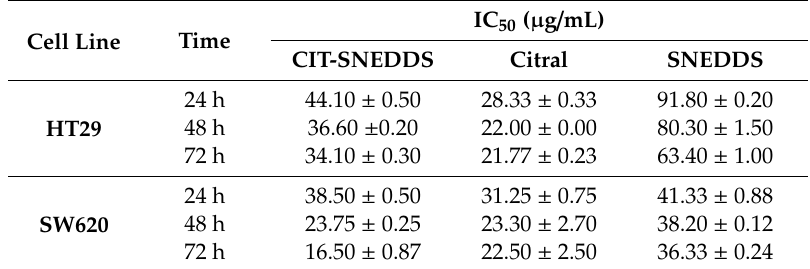
Table 6. The summary of antiproliferative e ff ects of citral-loaded self nano-emulsifying drug delivery system (CIT-SNEDDS), self nano-emulsifying drug delivery system (SNEDDS) and pure Citral alone towards HT29 and SW620 colon cancer